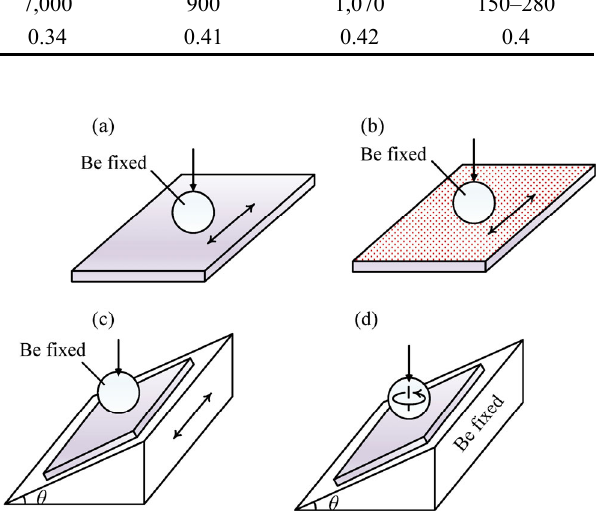
Fig. 3 Schematic of different contact forms: (a) friction between a polymer sphere and a smooth silicon surface; (b) friction between a polymer sphere and a rough silicon surface; (c) friction between a polymer sphere and a smooth inclined silicon surface; and (d) rotation of a polymer sphere on a smooth inclined silicon surface.